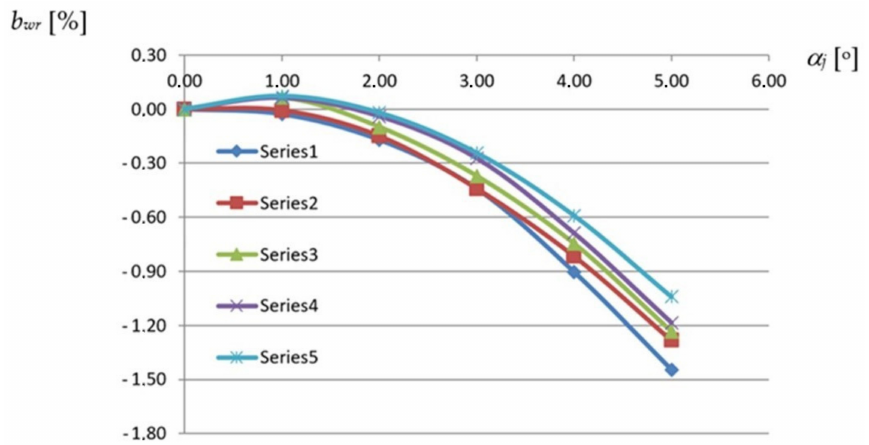
Figure 19. Nonlinear relations between the relative width increments b wr at a half along the fold’s length and the unit angle α j obtained for various profiles of a shell fold supported with straight directrices: Series1—TR50 × 0.75 mm × 8.0 m; Series2—T55 × 0.88 mm × 6.2 m; Series3—TR85 × 0.75 mm × 5.0 m; Series4—TR136 × 0.88 mm × 6.0 m; Serise5—T160 × 0.75 mm × 6.6